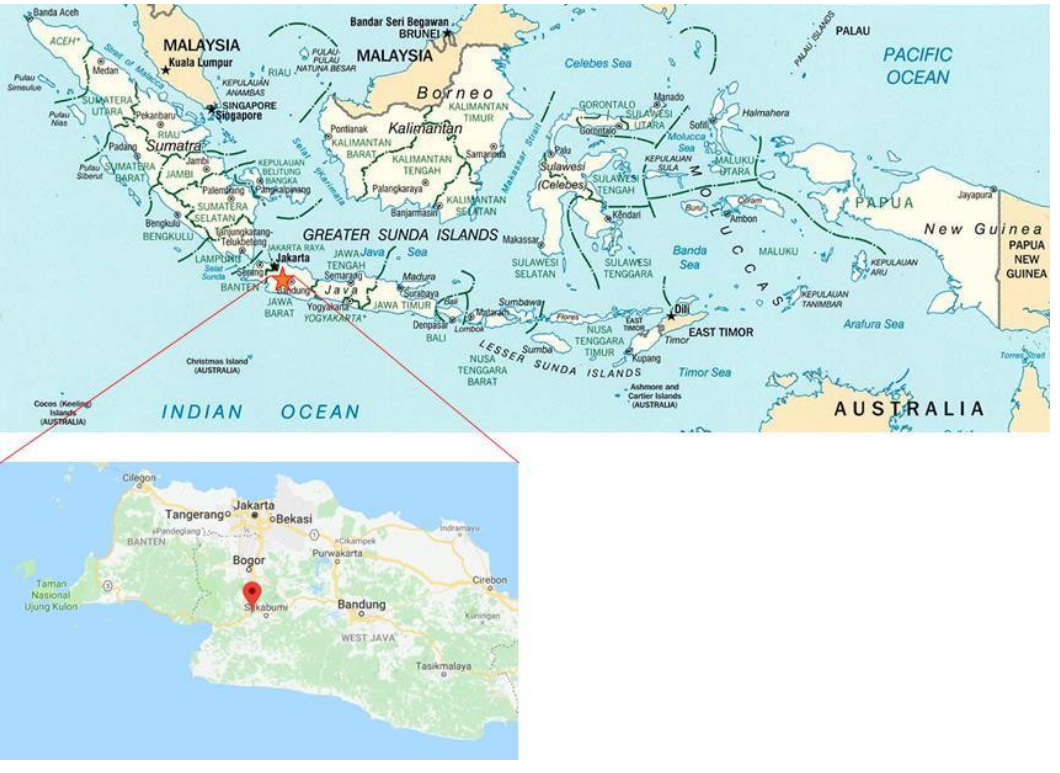
Figure 1. Location of the villages of Hegarmanah and Cicantayan as study sites in the Cicantayan Figure1. LocationofthevillagesofHegarmanahandCicantayanasstudysitesintheCicantayanDistrict, District, Sukabumi Regency, in West Java, Indonesia. (source: https: // www.mapsland.com / asia / indonesia). https://www.mapsland.com/asia/indonesia).